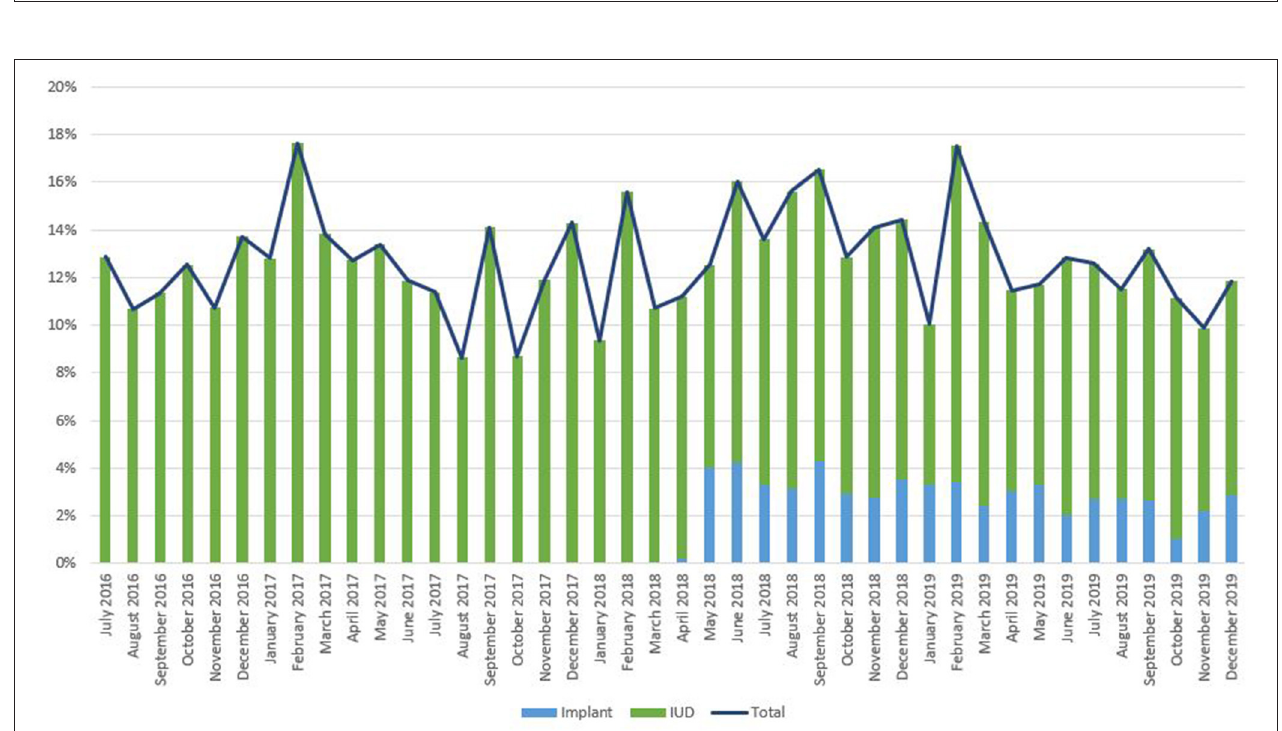
FIGURE 5 | Immediate postpartum IUD and implant uptake among all facility-based deliveries, July 2016-December 2019, Somalia.